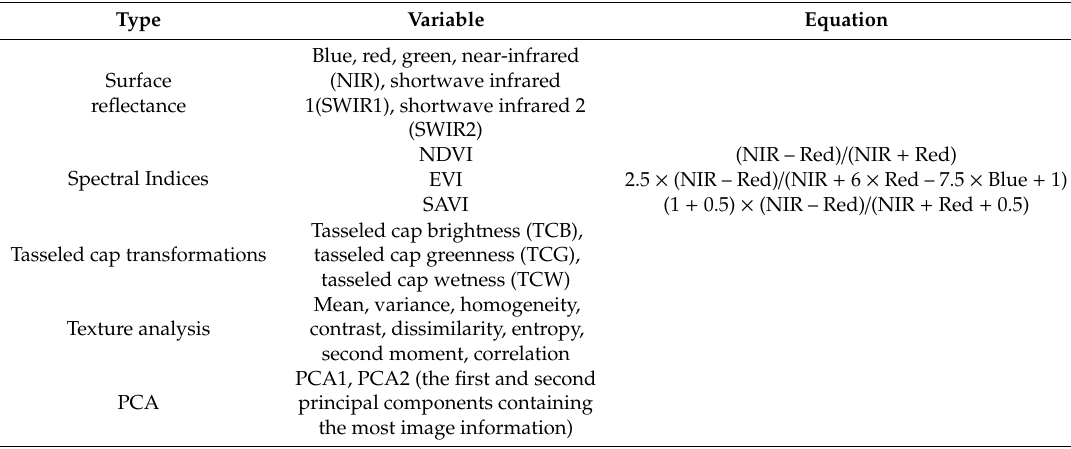
Table 4. The predictor variables for aboveground biomass (AGB)